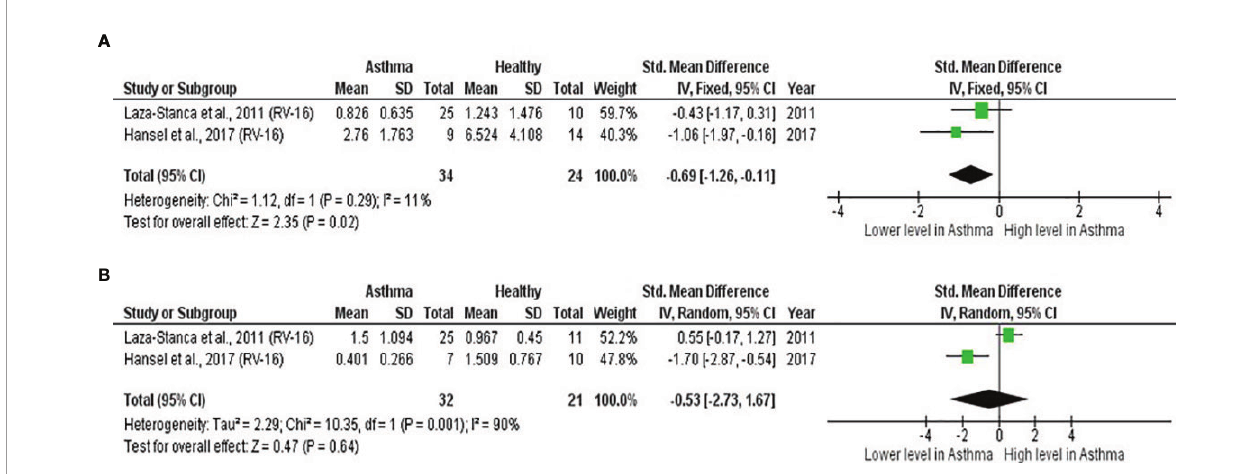
FIGURE 5 | Forest plot of (A) baseline and (B) post-infection IL-15 for adult atopic asthmatics vs non-atopic healthy adults experimentally infected with RV. (A) Atopic asthmatics had signi fi cantly lower levels of bronchial IL-15 at baseline compared to non-atopic healthy individuals (ES: - 0.69, p = 0.020). (B) Atopic asthmatics also had lower levels of bronchial IL-15 following experimental inoculation with RV compared to non-atopic healthy individuals (ES: -0.53), but the difference was not statistically signi fi cant ( p =